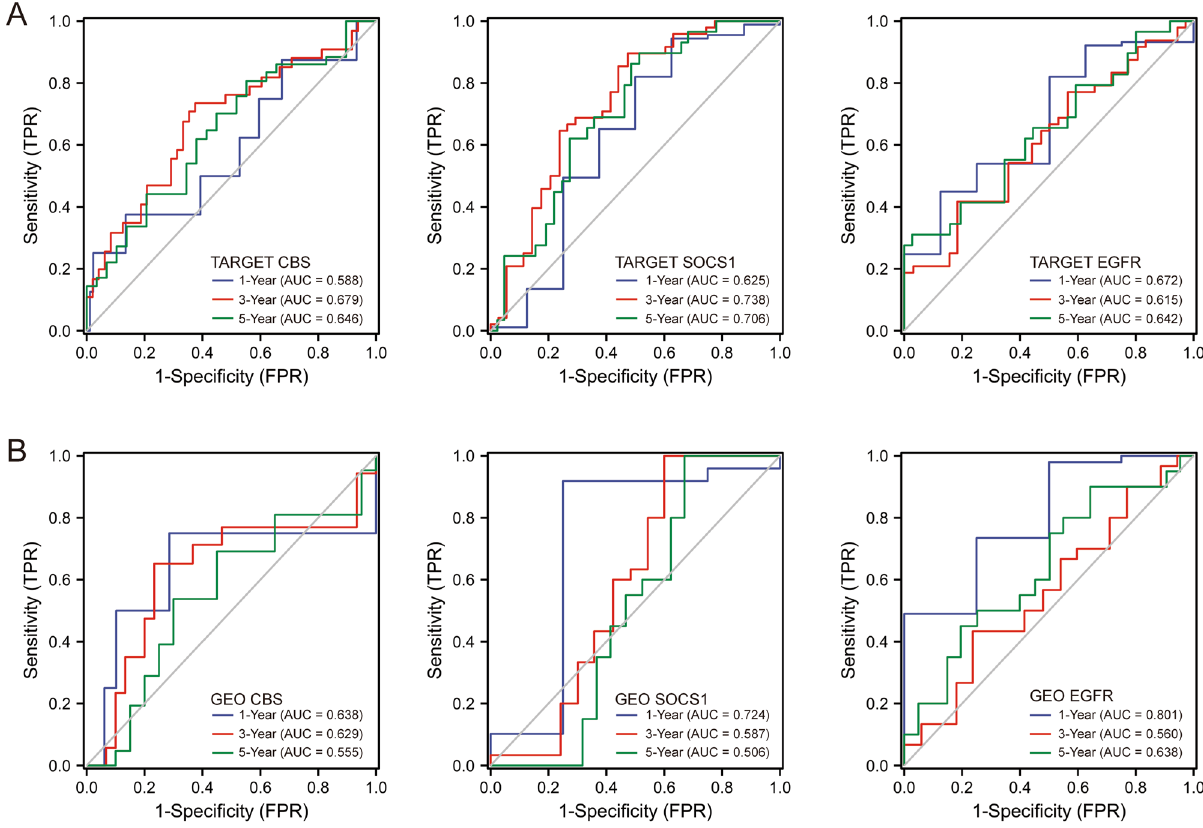
Figure 6. Time-dependent ROC curves of hub genes for OS patients. ( A ) Internal validation via a cohort of 99 samples from the TARGET database. ( B ) External validation via a cohort of 53 samples from the GSE21257